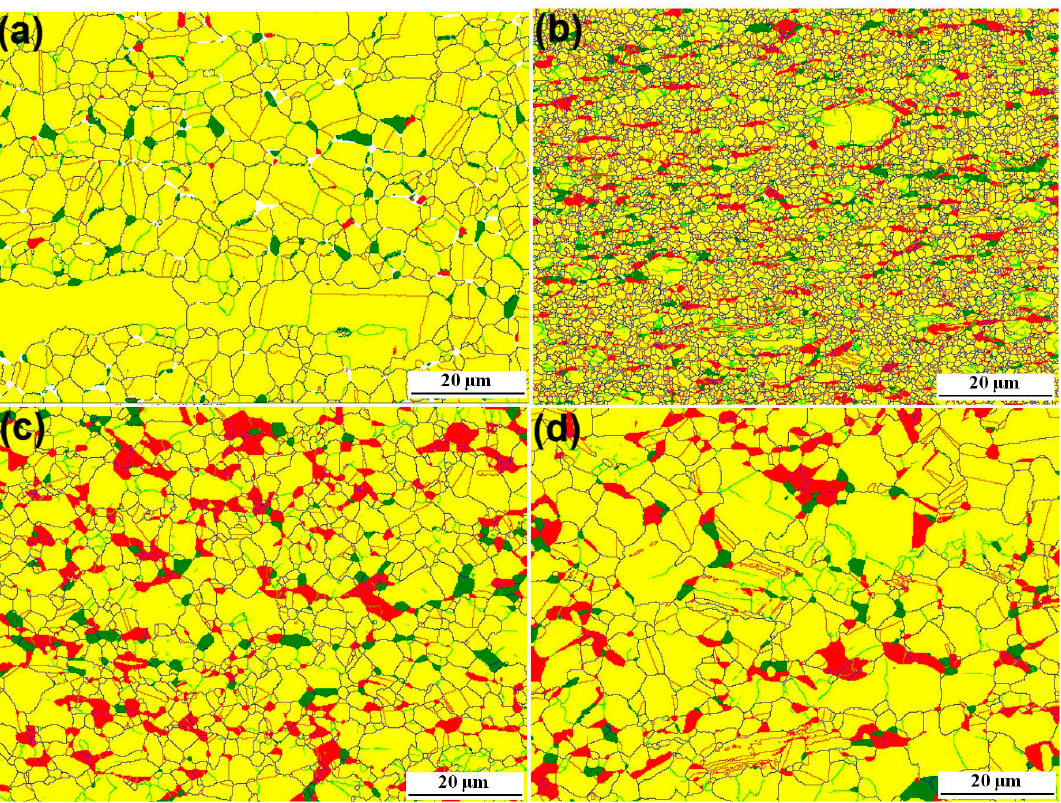
Figure 2. EBSD-derived phase maps with highlighted boundaries showing the microstructure of the alloy prior to ( a ) and after compression deformation under 1000 °C with the strain rate of 10 − 2 s − 1 ( b ) and 5 × 10 − 4 s − 1 ( c ) and under 1050 °C with the strain rate of 10 − 4 s − 1 ( d ). (Yellow— γ phase, red— α 2 phase, green— β / β o phase; blue line—high angle grain boundaries (HAGB), green line—low angle grain boundaries (LAGB), red line—twin boundaries (TB)).